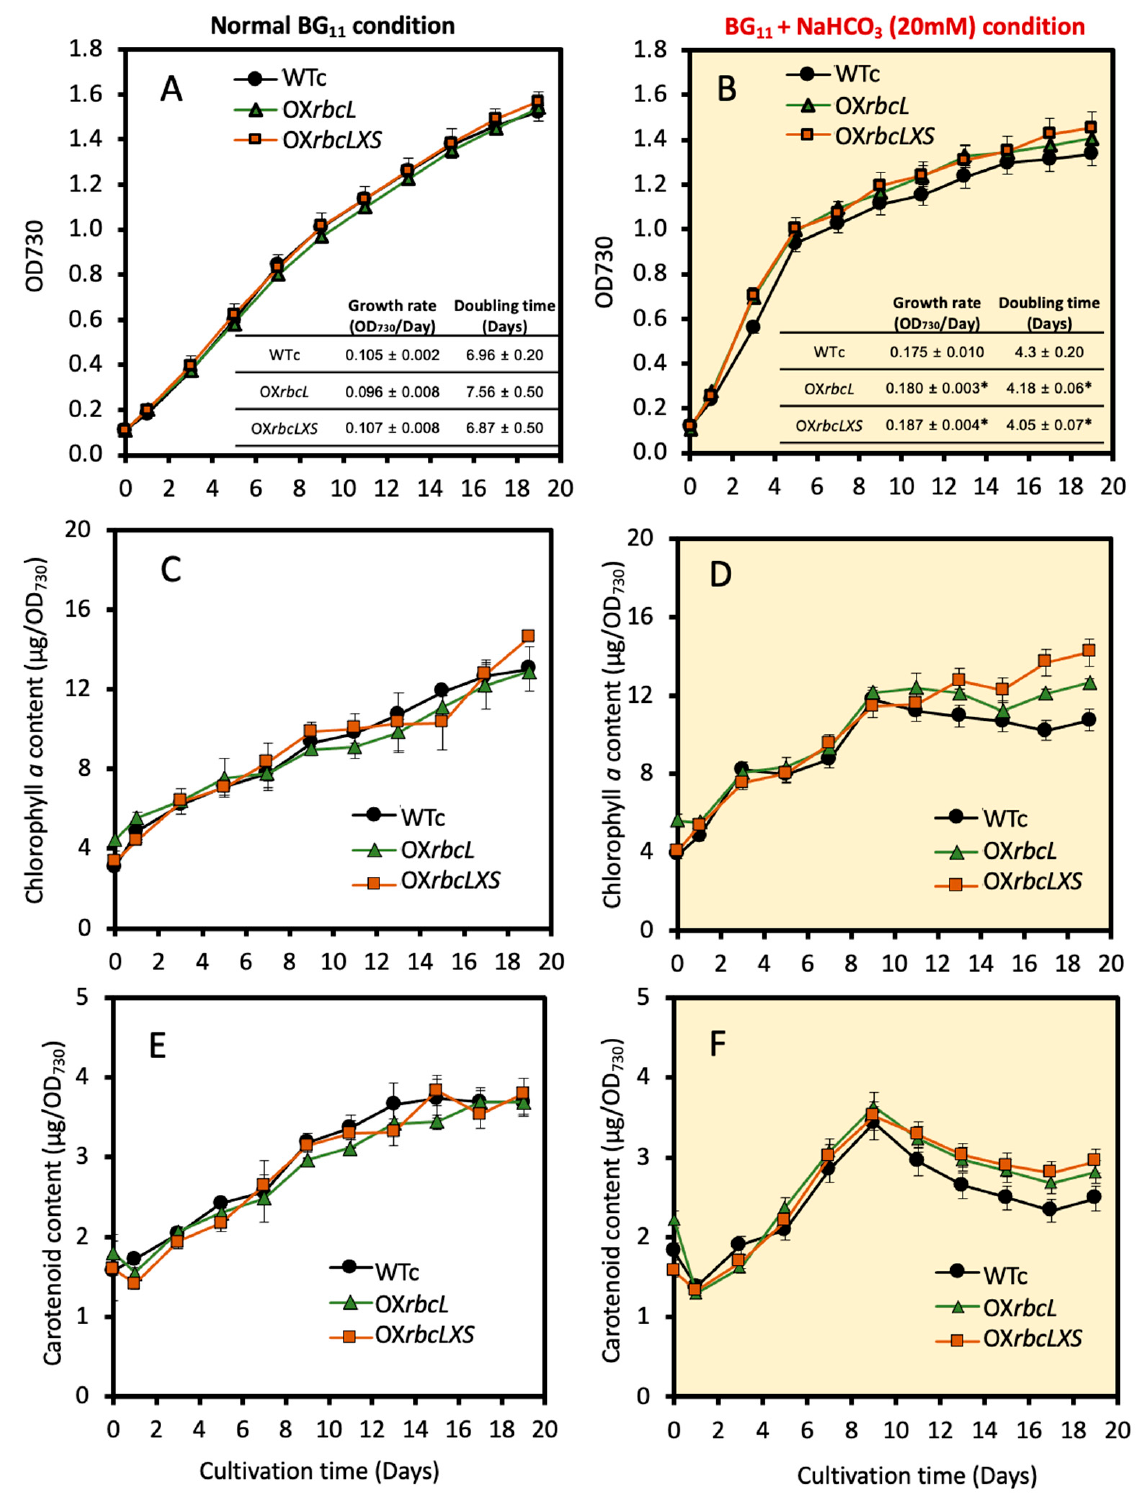
Figure 3. Optical density at 730 nm ( A , B ), chlorophyll a contents ( C , D ), and carotenoid contents ( E , F ) of Synechocystis WTc, OX rbcL , and OX rbcLXS strains grown in normal BG 11 medium and BG 11 medium containing 20 mM NaHCO 3 (BG 11 + NaHCO 3 condition), respectively, for 19 days. In ( A,B ), the growth rates and doubling times are provided as table insets. The statistical difference of the data between the values of WT and the engineered strain is represented by an asterisk at * p < 0.05. The error bars represent standard deviations of means (means ± S.D., n = 3).